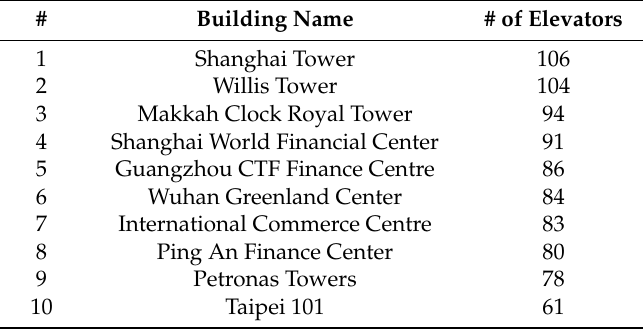
Table 3. Number of elevators in major tall buildings